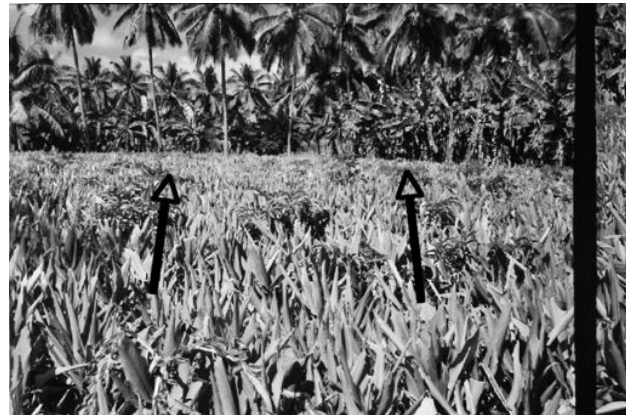
Fig. 1 - Elephant foot yam as an intercrop with turmeric. Arrows indicate elephant foot yam plants.